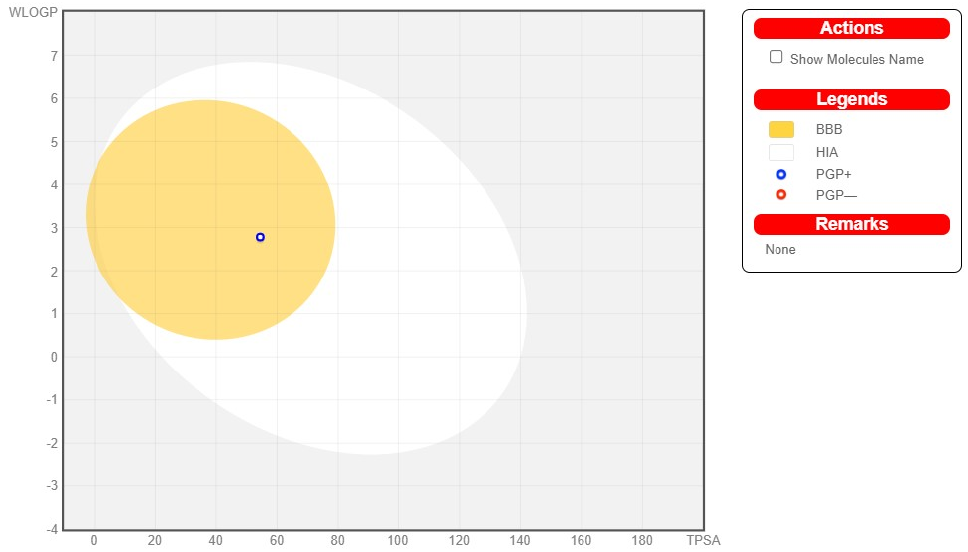
Figure 13. BOILED-Egg diagram for the ligand L2 .